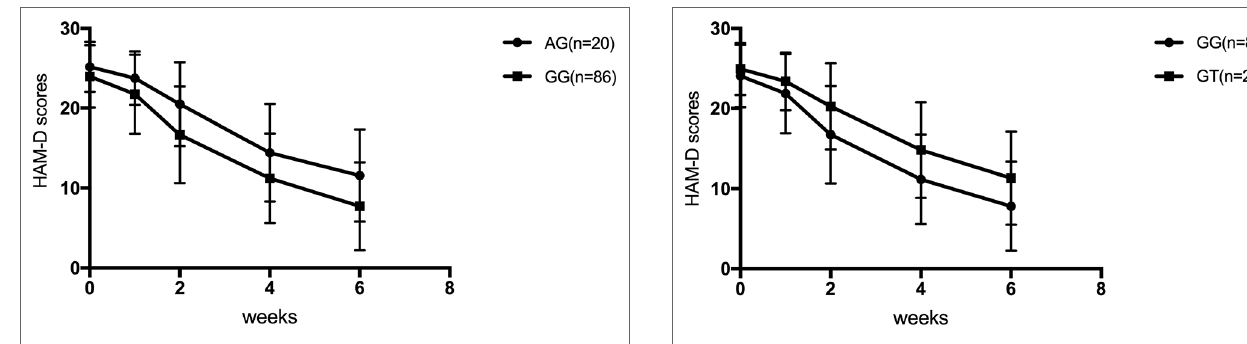
FIGURE 4 | HAM-D scores at the first, second, fourth, and sixth week